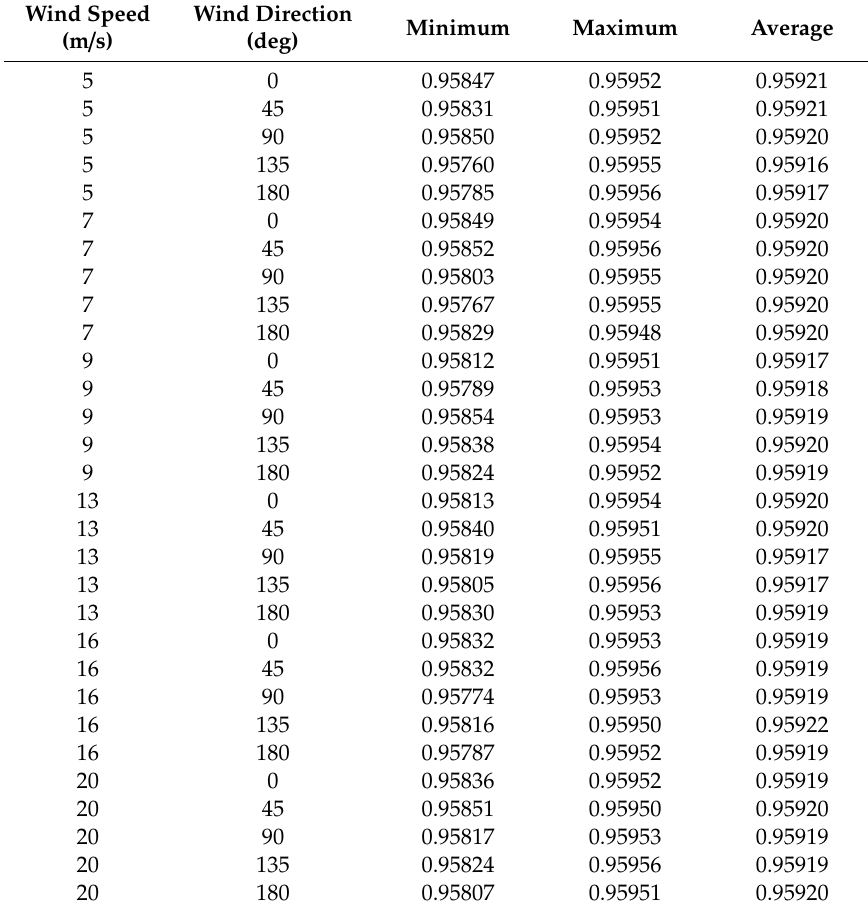
Table 6. Statistical results of the transmittance of 1000 pulse